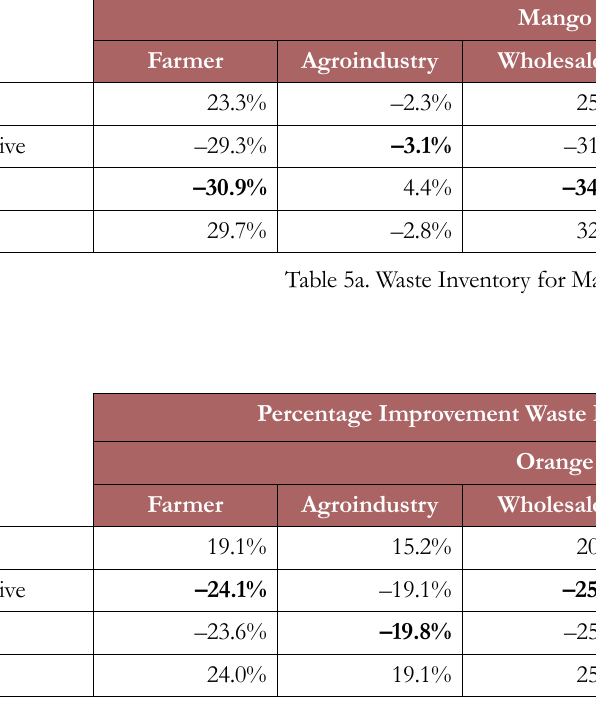
Table 5b. Waste Inventory for Orange